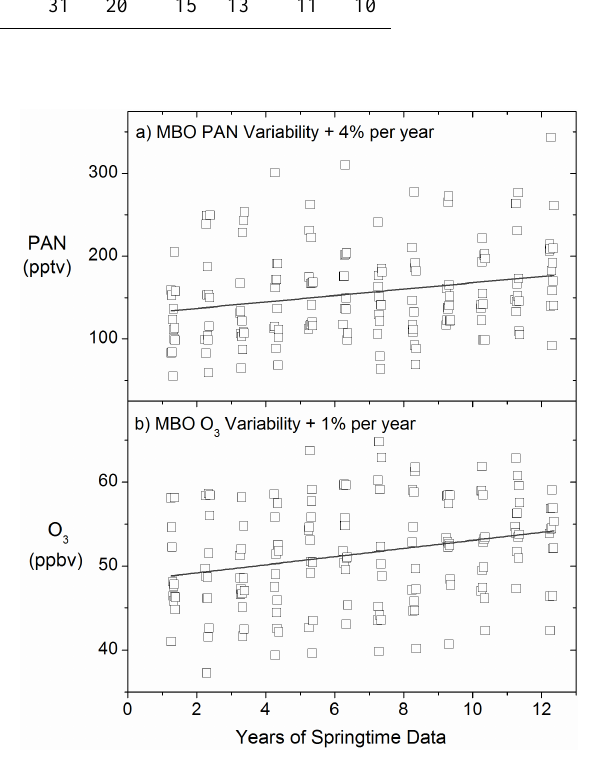
Figure 5: a) Random distribution of 4-day average springtime PAN mixing ratios at MBO for 972 Fig. 5. (a) Random distribution of 4-day average springtime PAN the period 2008 - 2010 propagated forward with a + 4% per year trend. The R 2 and p-values for 973 mixing ratios at MBO for the period 2008–2010 propagated forward with a +4% per year trend. The R 2 and p-values for this example this example are 0.06 and 2.8*10 -3 respectively. b) Random distribution of 4-day average 974 are 0.06 and 2.8 × 10 − 3 , respectively. (a) Random distribution of springtime O 3 mixing ratios at MBO for the period 2004 - 2009 propagated forward with a + 1% 975 4-day average springtime O 3 mixing ratios at MBO for the period 2004–2009 propagated forward with a +1% per year trends. The per year trends. The R 2 and p-values for this example are 0.07 and 6.6*10 -4 respectively. The 976 R 2 and p -values for this example are 0.07 and 6.6 × 10 − 4 , respec- time series are examples of those used to determine the probability of trend detection. Linear fits 977 tively. The time series are examples of those used to determine the are shown for each time series. See Table 1 for a range of PAN and O 3 trends. 978 probability of trend detection. Linear fits are shown for each time series. See Table 1 for a range of PAN and O 3 979